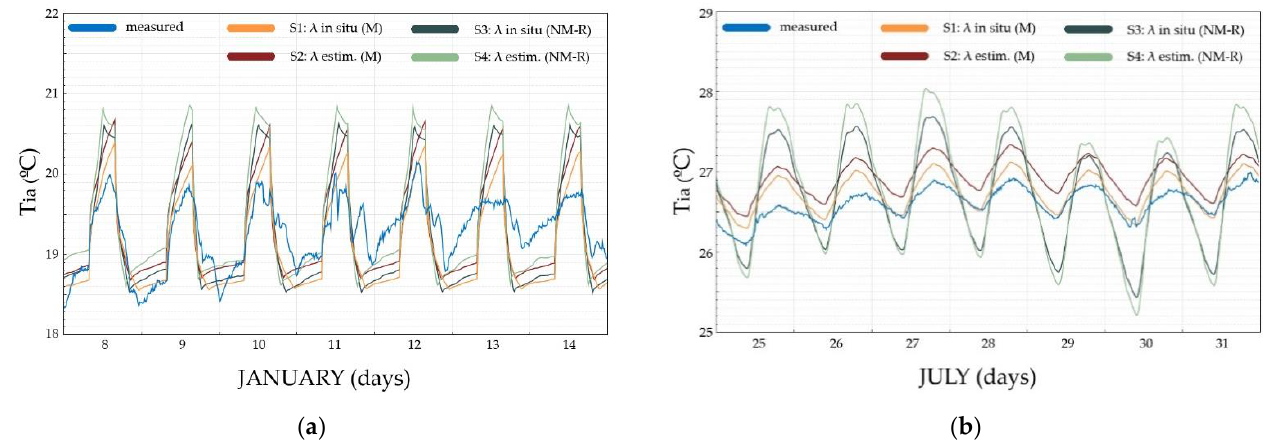
Figure 4. Indoor Air Temperature (T ia, °C). Measured values vs. simulations: ( a ) 8 – 14 January 2018 ( b ) 25 – 31 July 2018.